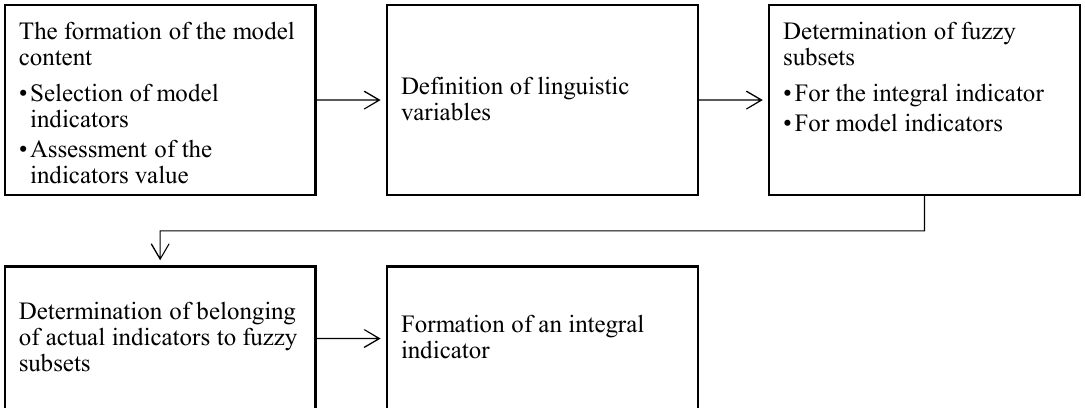
Figure 2. General algorithm for building fuzzy-multiple estimation models. Source: developed by the authors.